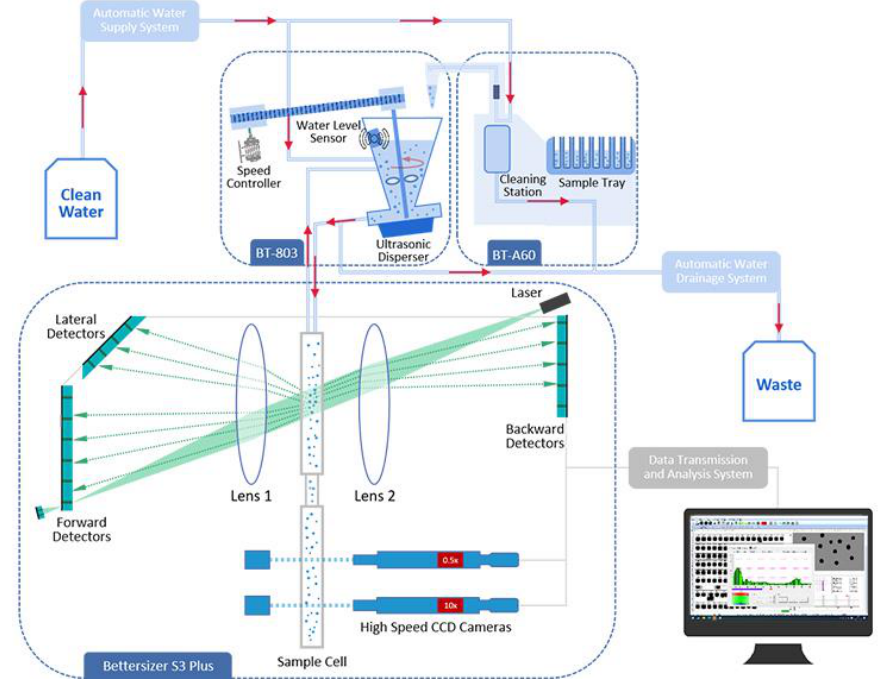
Figure 8. Detailed diagram of a soil sample test procedure on the Bettersizer S3 Plus laser particle size analyzer located in the Department of Military Engineering and Infrastructure of the MUT (reprinted from Ref. [55]).